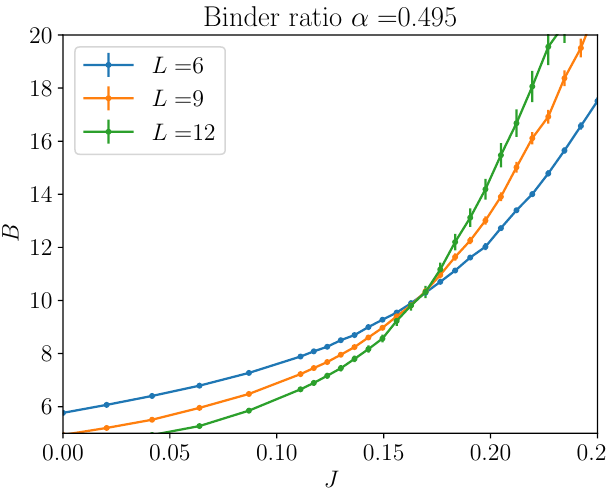
Figure 5: Binder ratio (10) at α = 0.495. The crossing for different system sizes signifies a second order transition (which is expected to be in O ( 3 ) universality with cubic anisotropy), and the critical value J is extracted. The black dots in Fig. 2 are c obtained in this